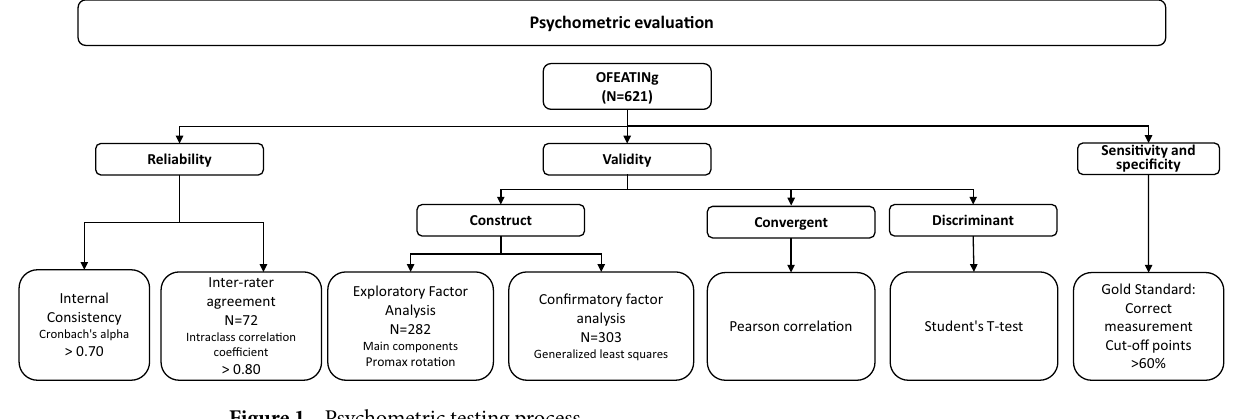
Figure 1. Psychometric testing